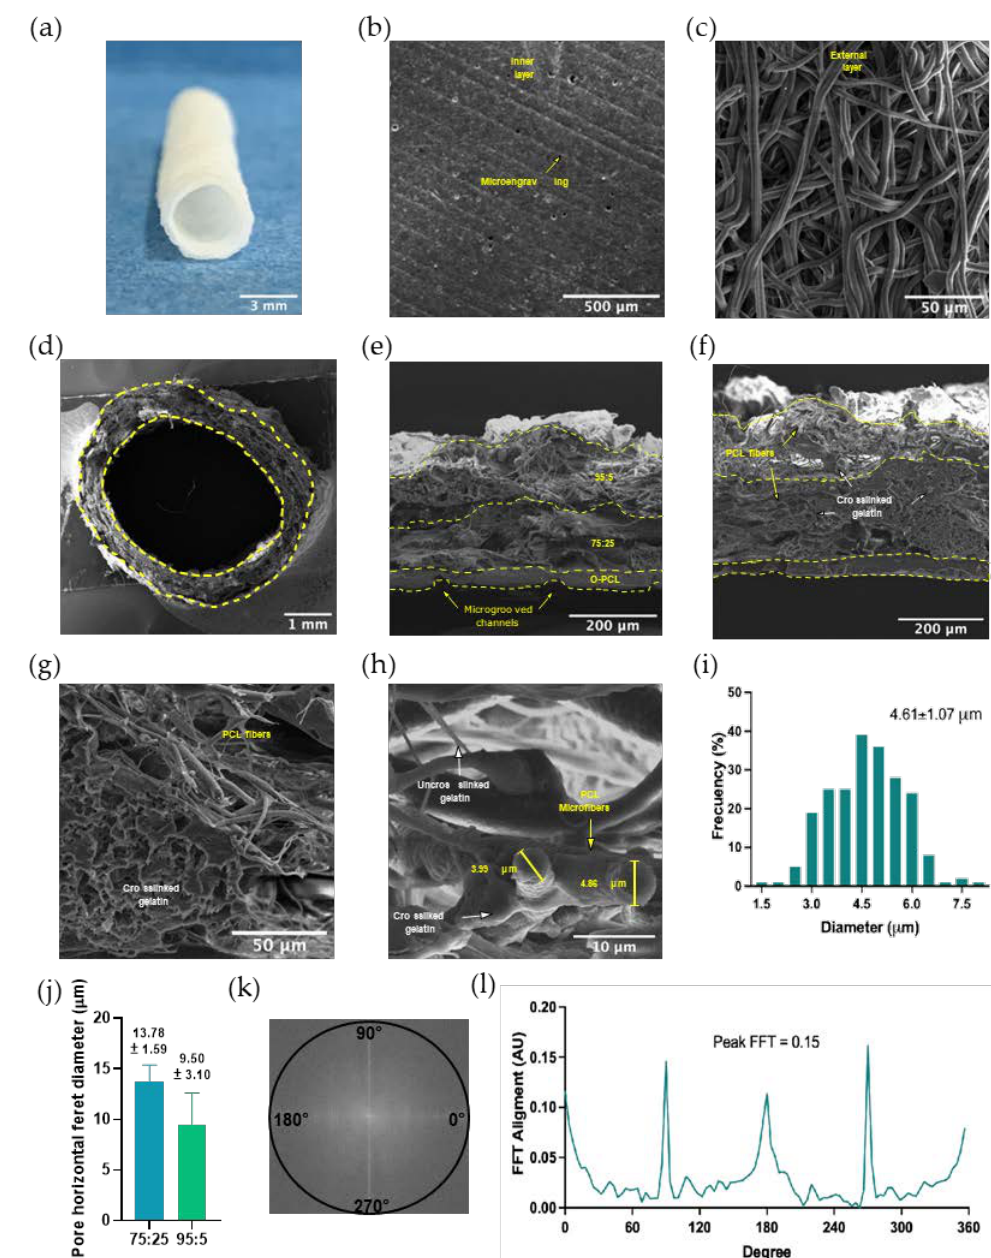
Figure 6. PCL:gelatin hierarchical electrospun tubular scaffolds with an innermost layer of microgrooved oxidized PCL (O-PCL). ( a ) Macroscopic view of tubular scaffold with an internal diameter of about 3.2 mm. ( b ) SEM micrographs of the scaffold’s inner layer showing the microgrooved pattern fabricated via solvent casting and ( c ) of the external 95:5 (PCL:Gelatin) electrospun layer. Cross-sectional SEM visualization of ( d ) a cryofractured tubular PCL-based scaffold. SEM micrograph of a cryofractured tubular scaffold with perpendicular ( e ) and parallel ( f ) views in respect to the scaffold length. ( g ) Magnification of the interface between the 75:25 and 95:5 (PCL:gelatin) layers. ( h ) Representative cross-sectional view of a cryofractured PCL fiber and ( i ) histogram of the fiber diameter distribution. Horizontal ferret diameter of wall pores considered to be the smaller ( j ) ImageJ ® FFT frequency plot ( k ) and 2D FFT alignment plot ( l ) of SEM micrographs of electrospun fibers. The 2D FFT peak value and the high-frequency pixels placed away from the origin and toward the periphery of the frequency plot indicate an alignment fiber